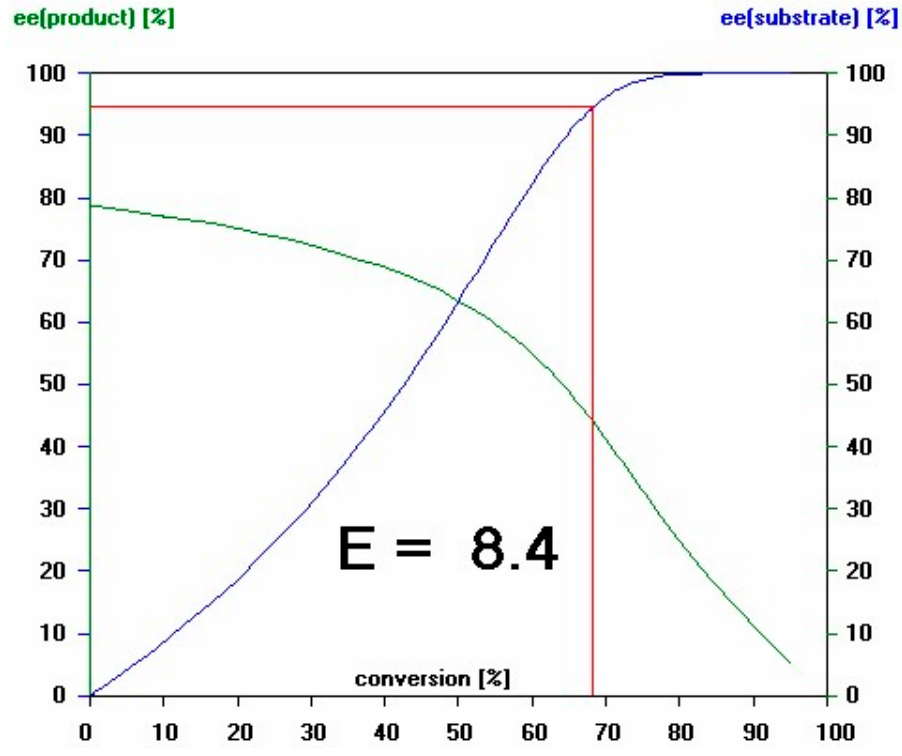
Figure 1. Plot of substrate & product e.e. vs. conversion for kinetic resolution of ( rac )- 4